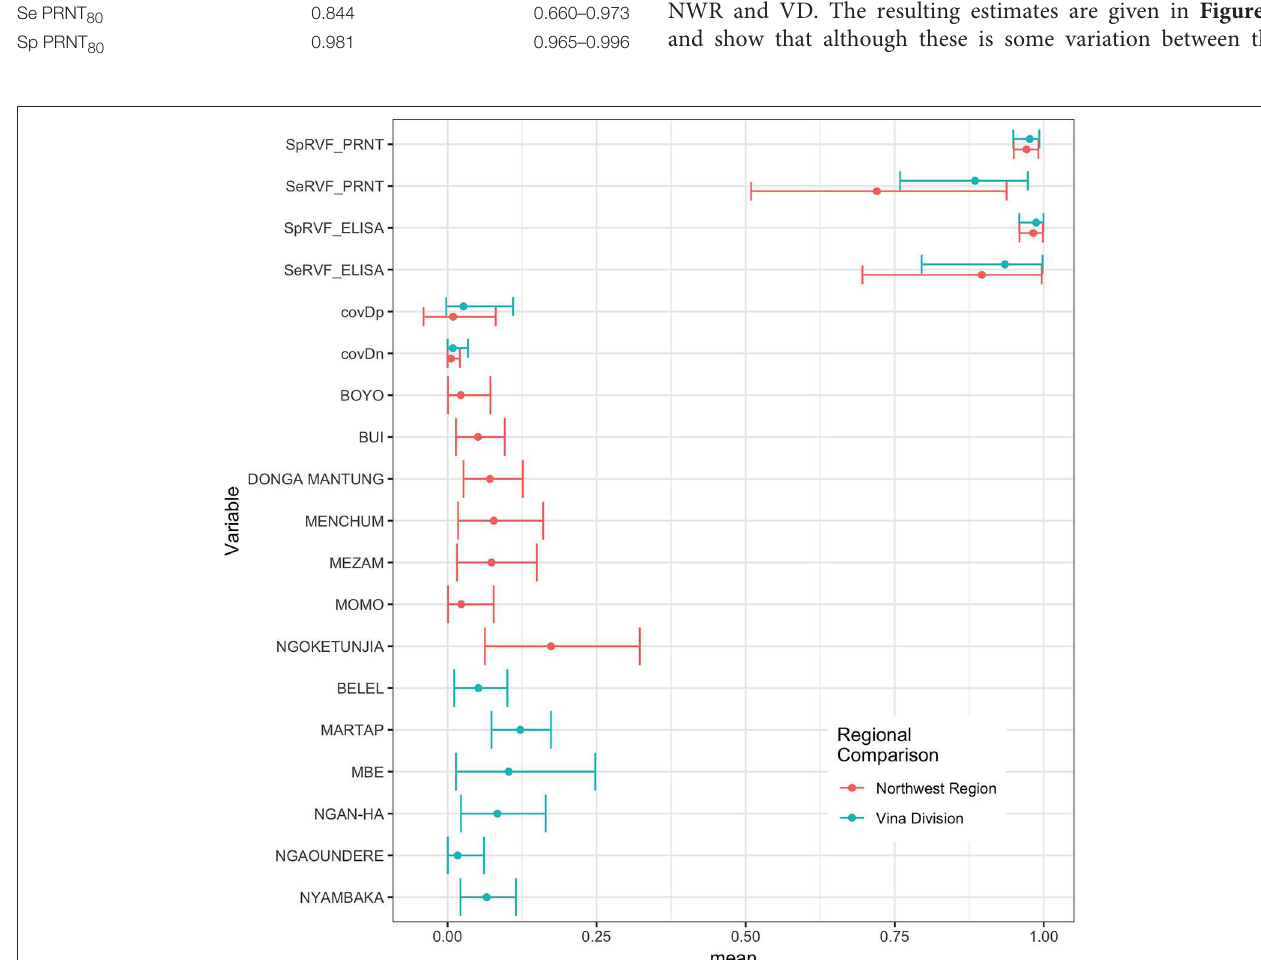
FIGURE 3 | Bayesian mean and 95% BCI for the ID.Vet ELISA (cut-off 40pp) and the PRNT 80 (cut-off 80) estimated independently in the two study sites in the Northwest Region and Vina Division.